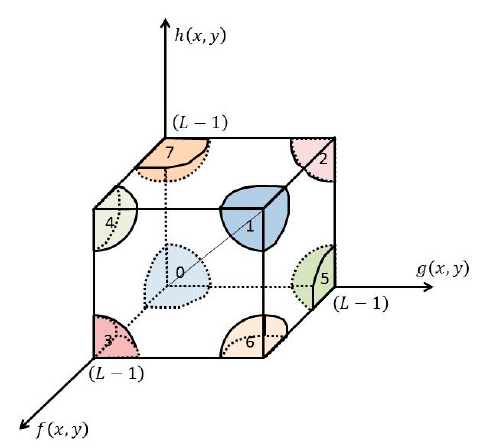
Figure 2. The model of 3D histogram reconstruction.